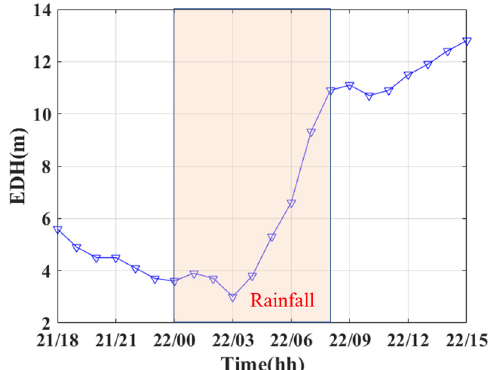
Figure 16. The EDH during the study period at position C. The light pink box indicates the rainfall period.